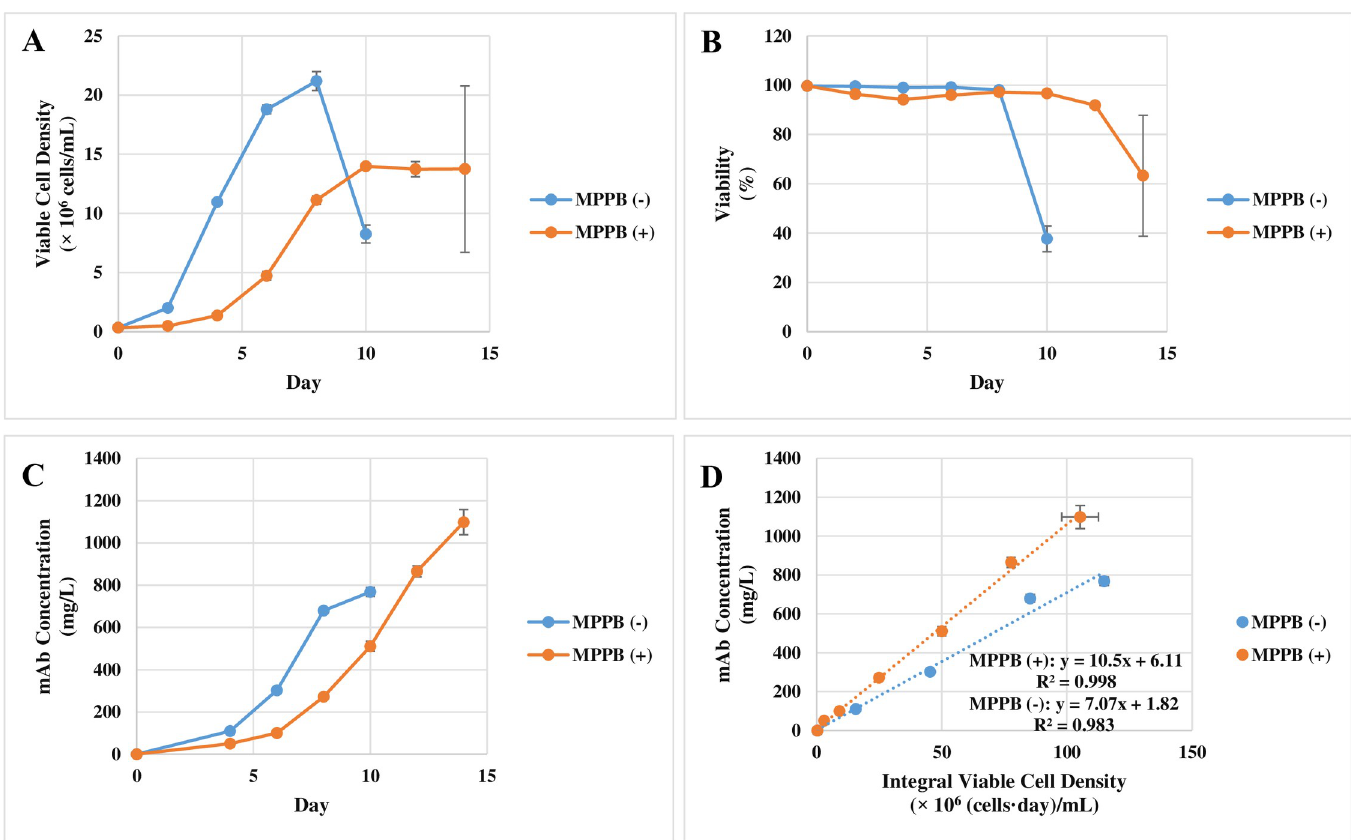
Fig 9. Cell culture profile and mAb production in the fed-batch cultures under the MPPB-added condition. MPPB at 0.64 mM was added to a culture on day 0, and 2% (v/v) feed medium was added on days 2, 4, and 6. Viable cell density ( A ) and viability ( B ) were measured every 2 days. The cell culture was continued until viability below 70% was reached. The slope of the mAb concentration ( C ) and integral viable cell concentration were used as cell-specific productivity ( D ) [28].